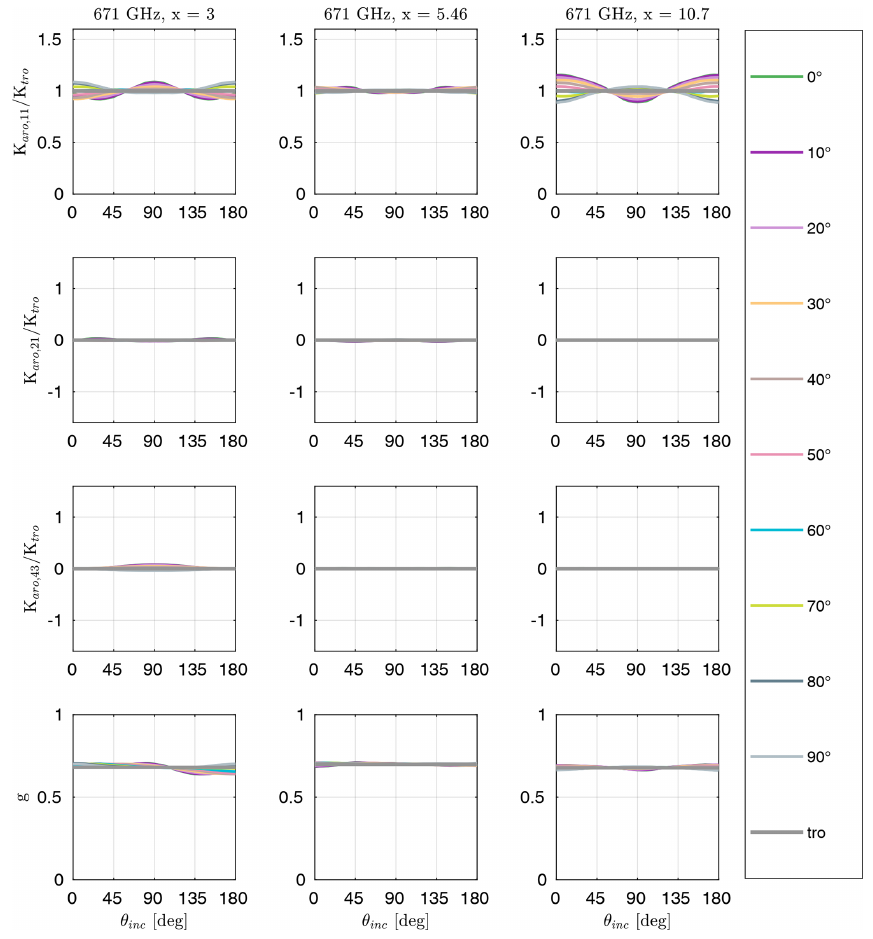
Figure 8. Extinction matrix elements K aro ,ij normalized by the extinction cross section for total random orientation and the asymmetry parameter g of large plate aggregate (hexagonal plate aggregate) for different size parameters x at 671GHz, as a function of incidence angle θ inc for several tilt angles β . The gray lines denote total random orientation. The shapes of the scatterers are shown in Fig.